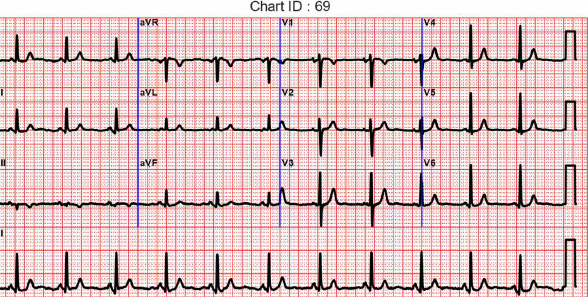
Figure 2. Sample of the ECG chart presented to cardiologists blinded to the source of the waveform, whether actual or derived from a subset of ECG